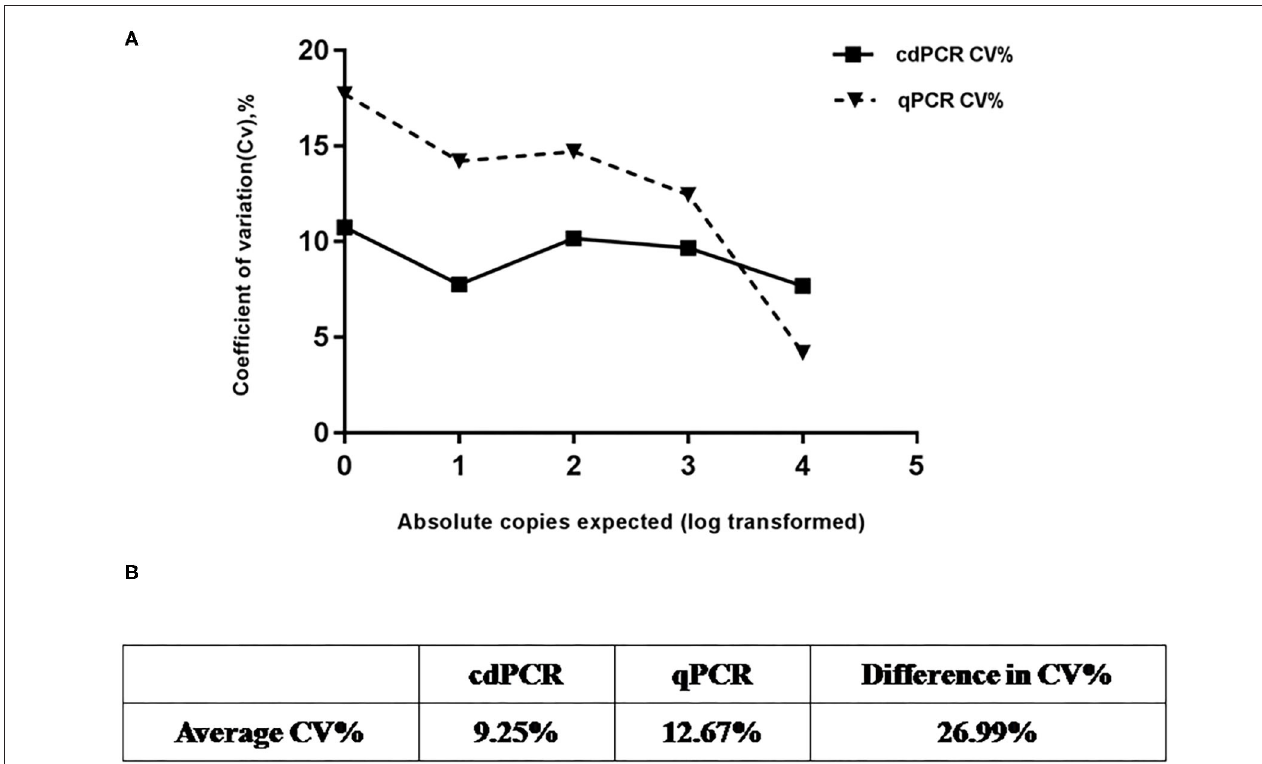
FIGURE 7 | Repeatability analysis. (A) Trend line comparing coefficient of variation (CV%) for cdPCR and qPCR at different concentration points. The square with the full line stands for CV % of cdPCR and the triangle with the dotted line indicated as the CV% of qPCR. (B) Table shows that average CV% value of cdPCR (9.25%) is lower than that of qPCR (12.67%).